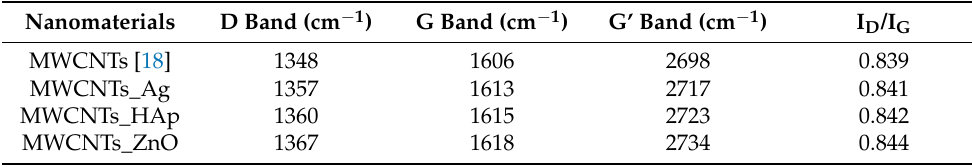
Table 1. Relative intensity of D, G and G’ bands and I D /I G band ratio of MWCNTs decorated with